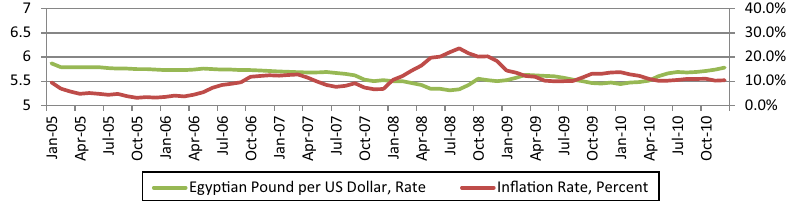
Figure 1. In fl ation rate